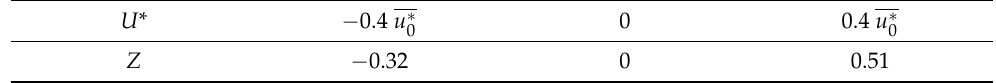
Table 2. The corresponding value of Z at various plane movement speeds.